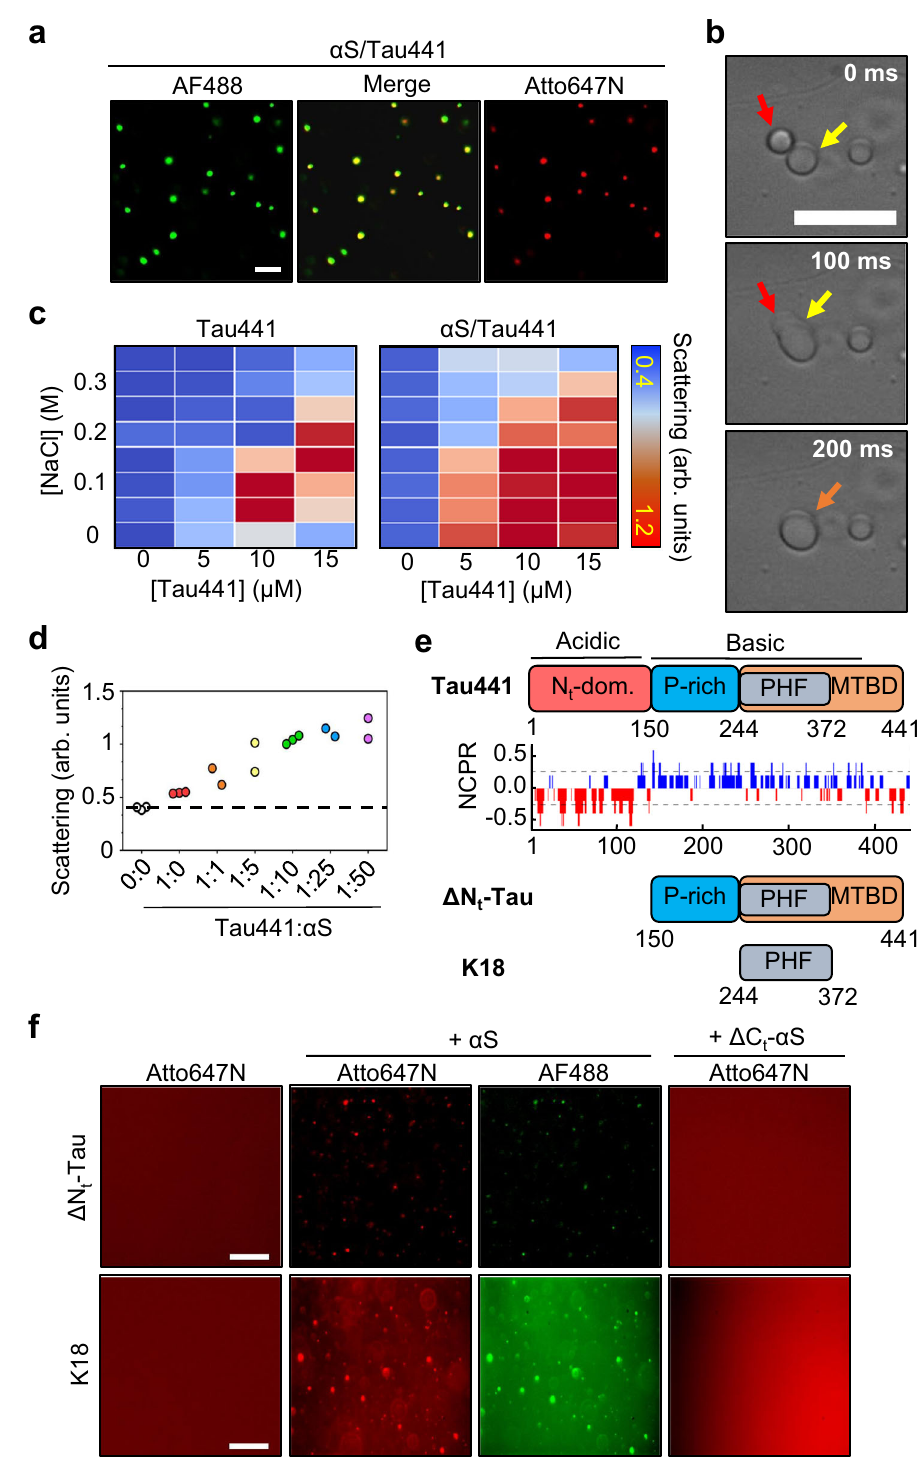
Fig. 2 | Complex electrostatic coacervation of α S with Tau. a Confocal (CF) microscopy images of α S/Tau441 coacervates in LLPS buffer (10 μ M each protein, 0.5 μ M AF488-labeled α S and Atto647N-labeled Tau441). b Representative differ- entialinterferencecontrast(DIC)microscopyimageofan α S/Tau441dropletfusion event (10 μ M each protein). c Light scattering-based (at 350nm) phase diagram of Tau441 LLPS (0 – 15 μ M) in the absence (left) or the presence (right) of 50 μ M α S. Warmer colors indicate more scattering. d Light scattering of α S/Tau441 LLPS samples with increasing concentrations of α S (Tau441 at 5 μ M, N =2 – 3 sample replicas,asindicated). e Schematicofsome of the Tauprotein variants used inthis